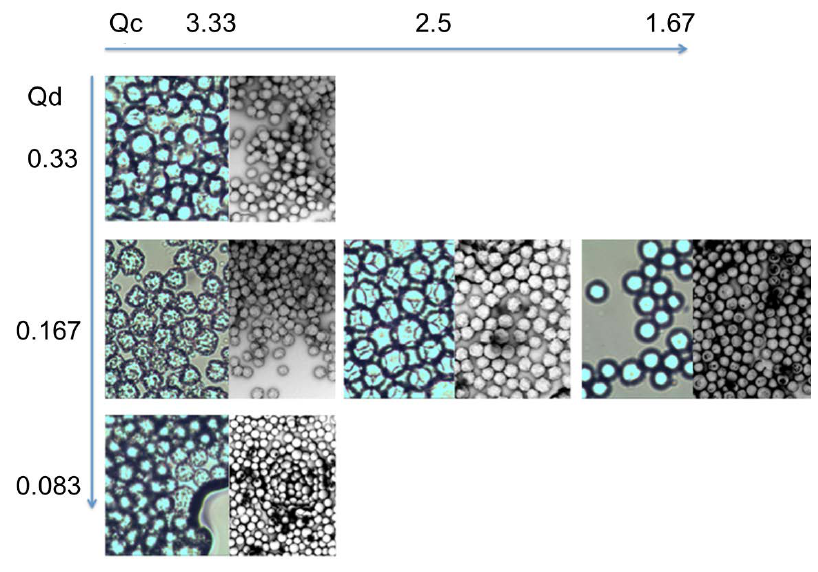
Figure 15. PLGA microspheres formed by microfluidic emulsification of DCM/PLGA solution droplets. SEM images show the effect of flow rates ( Q c = flow rate of continuous phase and Q d = flow rate of continuous phase) on the process stability and quality of the